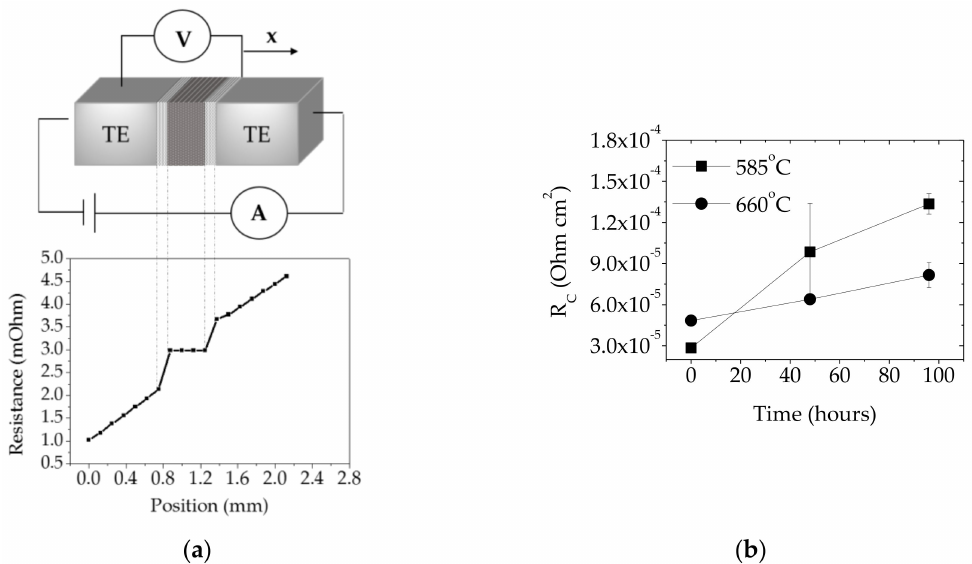
Figure 4. ( a ) Schematic illustration of four-point probe resistance set-up equipped with a scanning probe moving across the surface (x) where the contact resistance ( R c ) is defined as the ratio of voltage drop across the contact to the current pulse applied to a pair of contacts; the graph below shows R c measurement of the skutterudite specimen bonded at 660 ◦ C for 4.6 min and ( b ) R c evolution of metal interconnect– Mm y (Fe,Co) 4 Sb 12 p-type contacts as a function of isothermal ageing time. Note: As-joined contacts are denoted as ‘0 hours’ specimens.